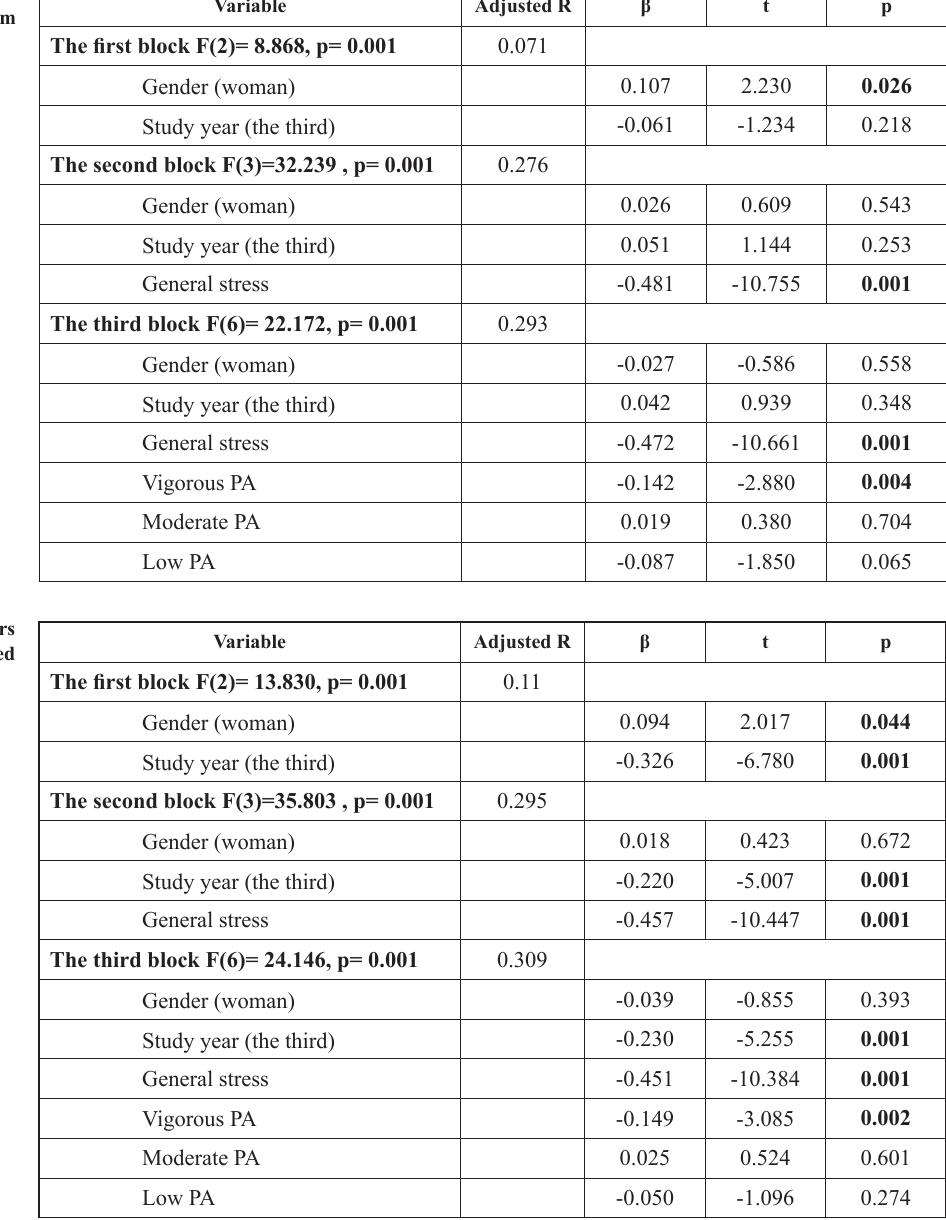
tors of training program and regime related stress